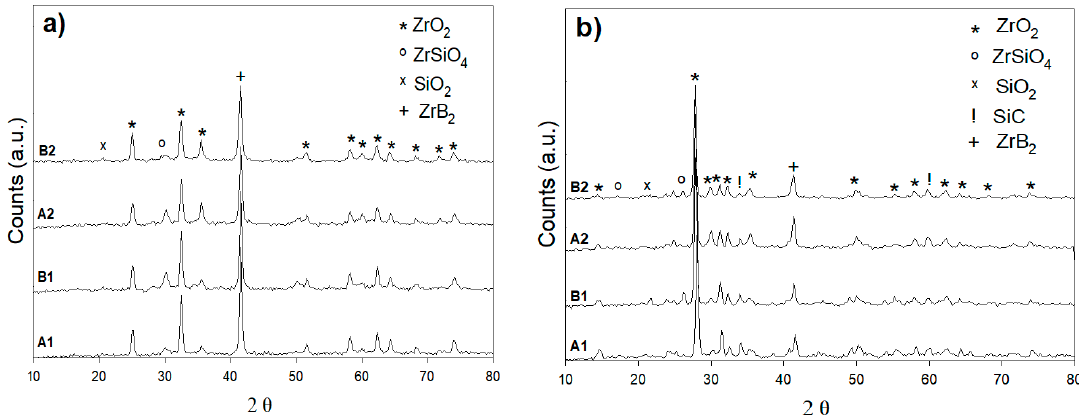
Figure 10. XRD patterns of the surface oxidation of A1, B1, A2, and B2 of ( a ) torch treatment for 5 min at 1000 °C and ( b ) furnace treatment for 30 min at 1000 °C.